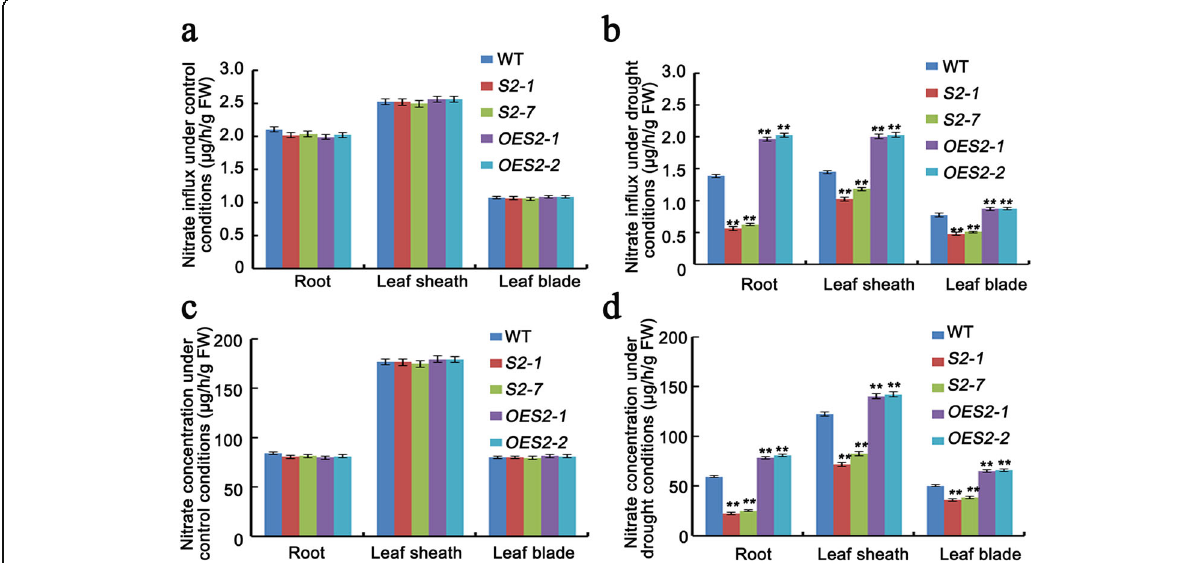
Fig. 5 SAPK2 influenced the rate of NO 3 − influx rate and nitrate concentration. a-b Analysis of NO 3 − influx rate among WT, sapk2 mutant lines and OE lines under control conditions ( a ) and drought stress conditions ( b ). c-d Analysis of nitrate concentration among WT, sapk2 mutant lines and OE lines under control conditions ( c ) and drought stress conditions ( d ). Data are shown as means ± SD ( n = 20) from three replicates. A student ’ s t -test was used to generate P values; “ ** ” indicate significance at P <